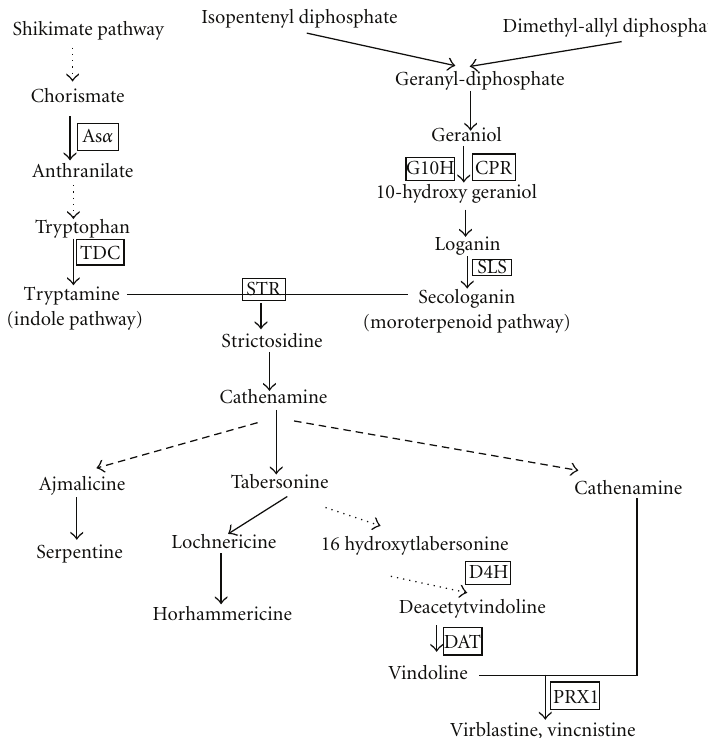
Figure 1: TIAs biosynthetic pathway and relative genes in C. roseus . Unbroken arrows indicate single enzymatic conversions and broken arrows indicate multiple enzymatic